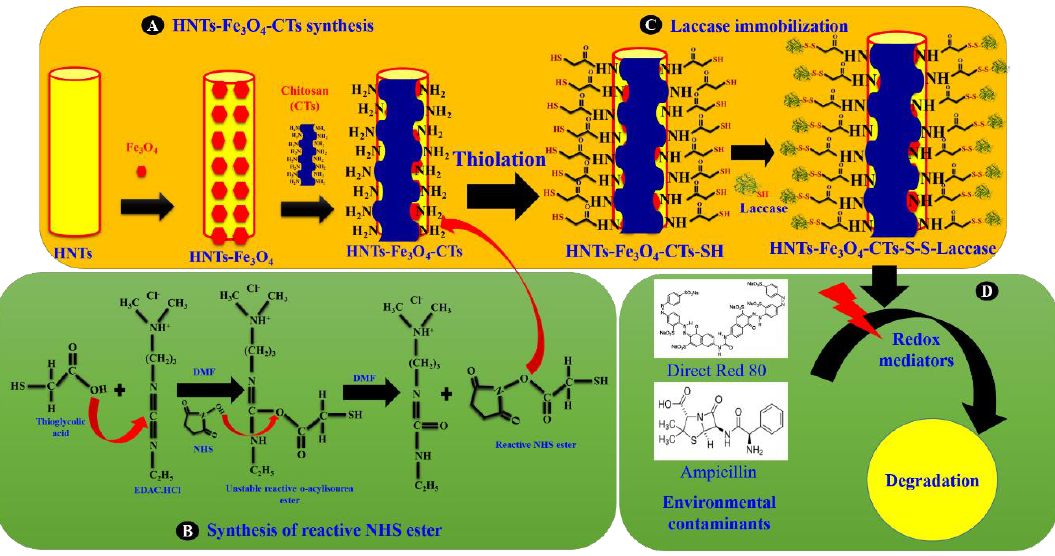
Figure 1. The schematic presentation of the synthesis of( A ) HNTs-Fe 3 O 4 -CTs, ( B ) reactive NHS ester, and ( C ) HNTs-Fe 3 O 4 -CTs-S-S-Laccase, and ( D ) degradation of the environmental contaminants Direct Red 80 and ampicillin by the immobilized laccase.